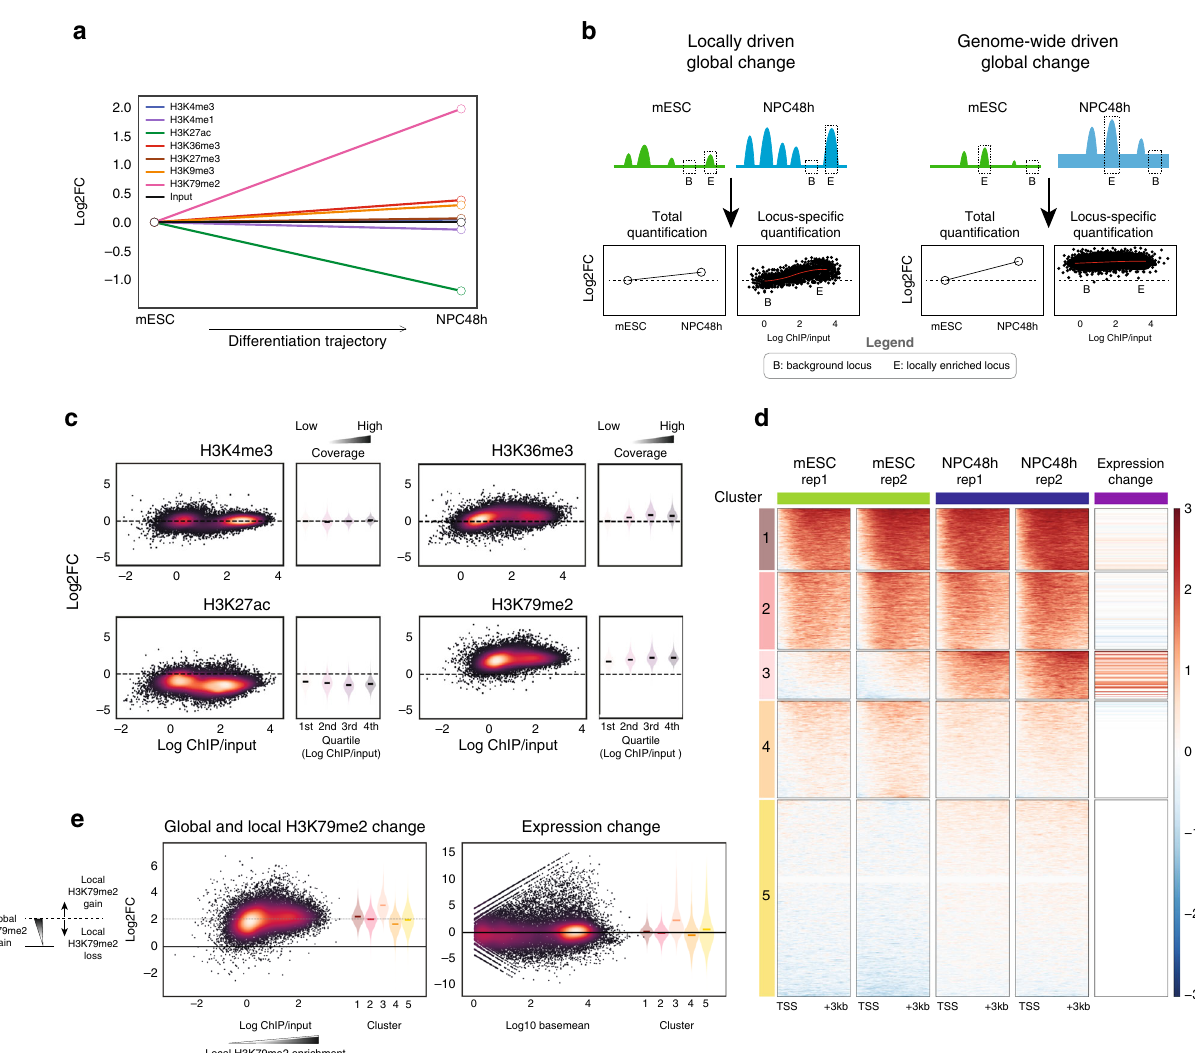
Fig. 2 H3K27ac and H3K79me2 undergo opposite global changes independent of transcriptional changes during in vitro neuronal differentiation. a Representation of the global scaling factors (log2 transformed) estimated in NPC48h using quantitative ChIP-seq with respect to the reference mESC level, for the seven histone modi fi cations included in this study ( N = 2). b Model to illustrate that global histone modi fi cation changes can result from two different scenarios. Left panel: locally driven global changes may follow from increased number and/or magnitude of histone PTM local enrichment. Right panel: genome-wide driven global changes may follow from a genome-wide accumulation of a mark on both locally enriched regions ( “ peaks ” ) and on background regions. c MA plots showing the mean coverage ( x -axis) and log2 fold-change ( y -axis) of four histone marks computed on bins overlapping annotated genomic features for the contrast NPC48h vs mESC (H3K4me3 and H3K27ac: transcription start site (TSS) ± 2 kb; H3K79me2: TSS + 3 kb; H3K36me3: transcription termination site (TTS) − 3 kb). Next to each MA plot, we show a summary plot showing the global fold-change distribution ( y - axis) for each quartile of mean coverage ( x -axis). d k-mean clustering ( k = 5) of H3K79me2 enrichment 3 kb downstream of TSS of protein-coding genes. A standard scaling method (by sequencing depth) and normalization (by input-control) was used. This highlights changes with respect to local background. The last column shows the log2 fold-changes in the expression of the respective genes in each cluster for the contrast NPC48h vs mESC. Genes gaining local H3K79me2 enrichment tend to be upregulated during in vitro neuronal differentiation. e Left panel: MA plot showing the mean coverage ( x -axis) and the global change in H3K79me2 ( y -axis) computed on a window 3 kb downstream of TSS of protein-coding genes, next to a violin plot showing the global H3K79me2 changes for each of the fi ve clusters previously identi fi ed in ( d ). The scheme on the right helps the interpretation of the global and local H3K79me2 changes. Right panel: MA plot of gene expression changes for the contrast NPC48h vs mESC, next to a violin plot showing the expression changes of genes clustered according to ( d